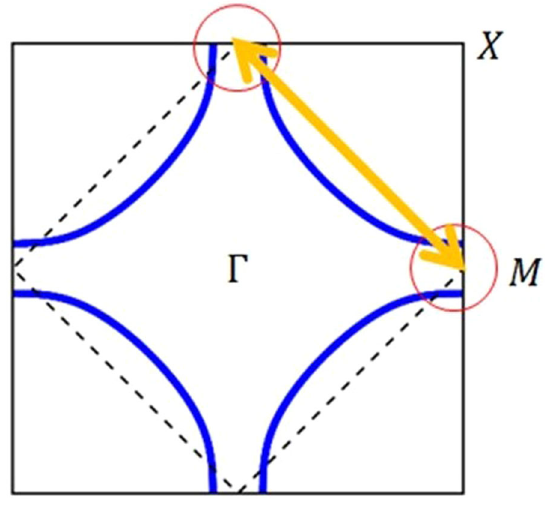
Fig. 1 Model Fermi surface. Antinode to antinode scattering induced by the disorder potential is indicated by the yellow arrow.